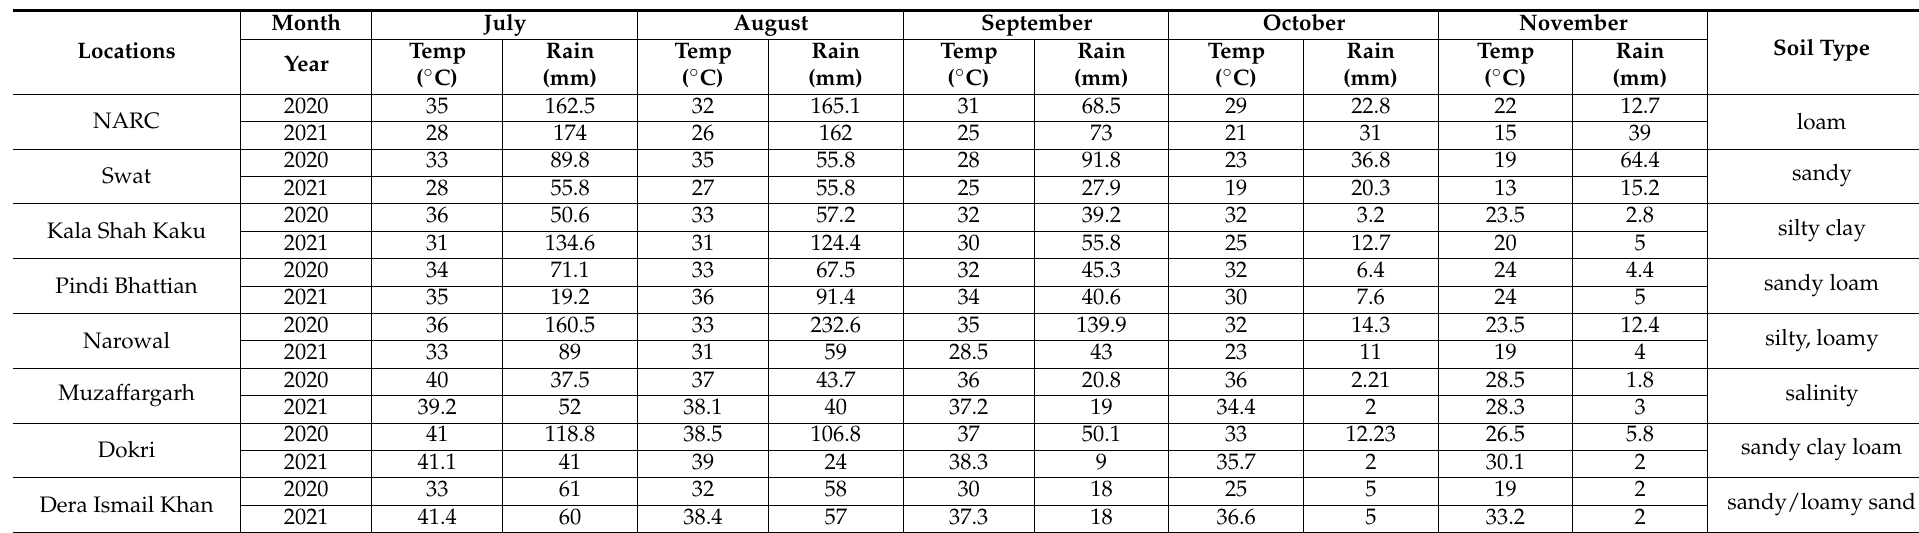
Table 2. Mean temperature, rainfall, and soil texture of each experimental site during 2020 and